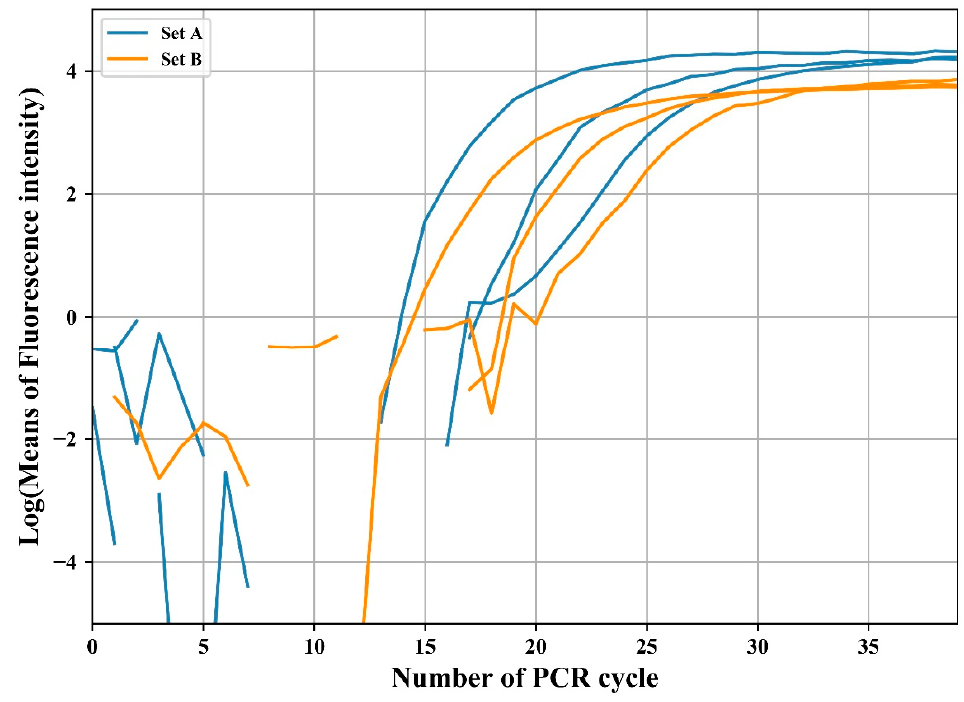
Figure 7. Logarithmic transformation of fluorescence intensity for threshold cycle determination.